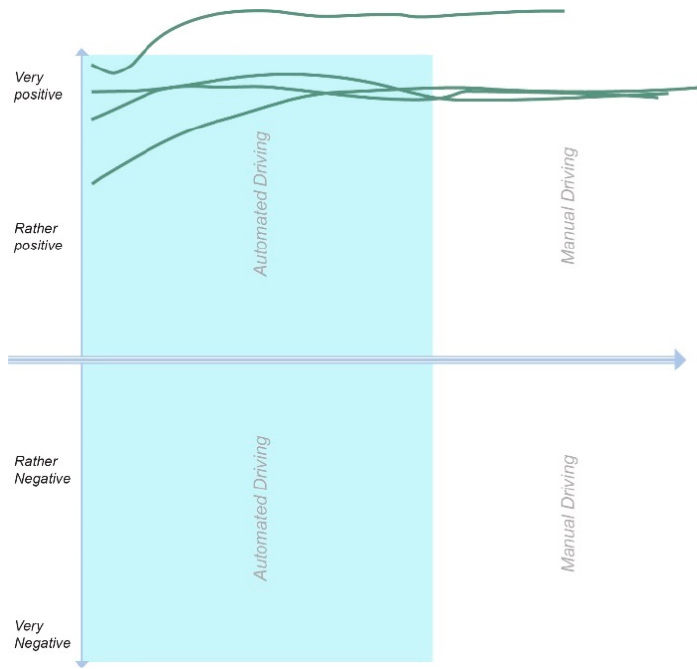
Figure 2. Curves with horizontal inclination. Upward inclination ( n = 2)—The curves with an upward inclination started on a lower level when using the automated driving system and ended up higher when driving manually again, indicating a more positive user experience when driving themselves. The participants who drew the curves with the upward inclination both stated that they prefer to drive themselves and experienced some issues during the take-over procedure. One participant explained why his UX-curve went from negative to positive “I was fairly quickly disappointed that it was doing its own thing and I was not in control ( . . . ) Then you know, it is a nice car to drive”